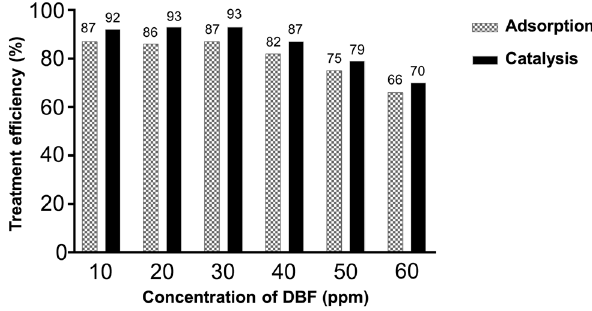
Figure 2: E ff ect of DBF concentration on the degradation e ffi ciency. Catalysis: [ H 2 O 2 ] = 10 mM; catalyst dosage = 10 mg, room tem - perature, time = 60 min. Absorption: adsorbent dosage = 10 mg, room temperature, time = 60 min.